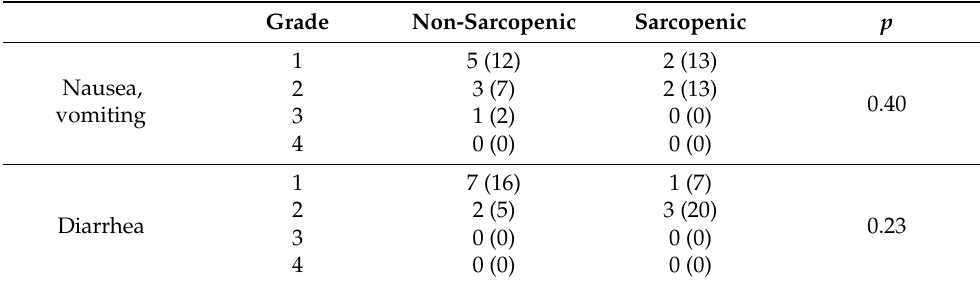
Table 5. Treatment toxicity according to the sarcopenia